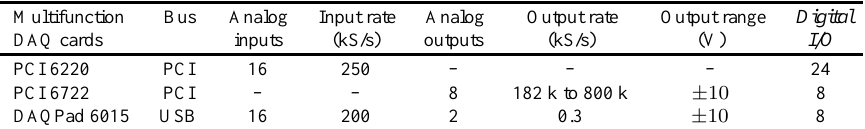
Table 3 Specifications of multifunction data acquisition cards in the